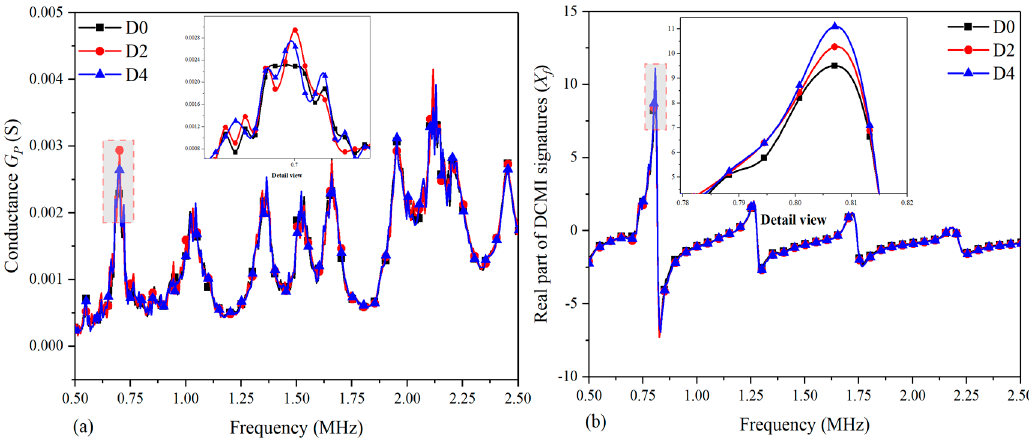
Figure 5. Comparative plots based on real part of signatures for specimen-1: ( a ) raw conductance signatures G P , ( b ) extracted direct coupling mechanical impedance (DCMI) signatures X f .